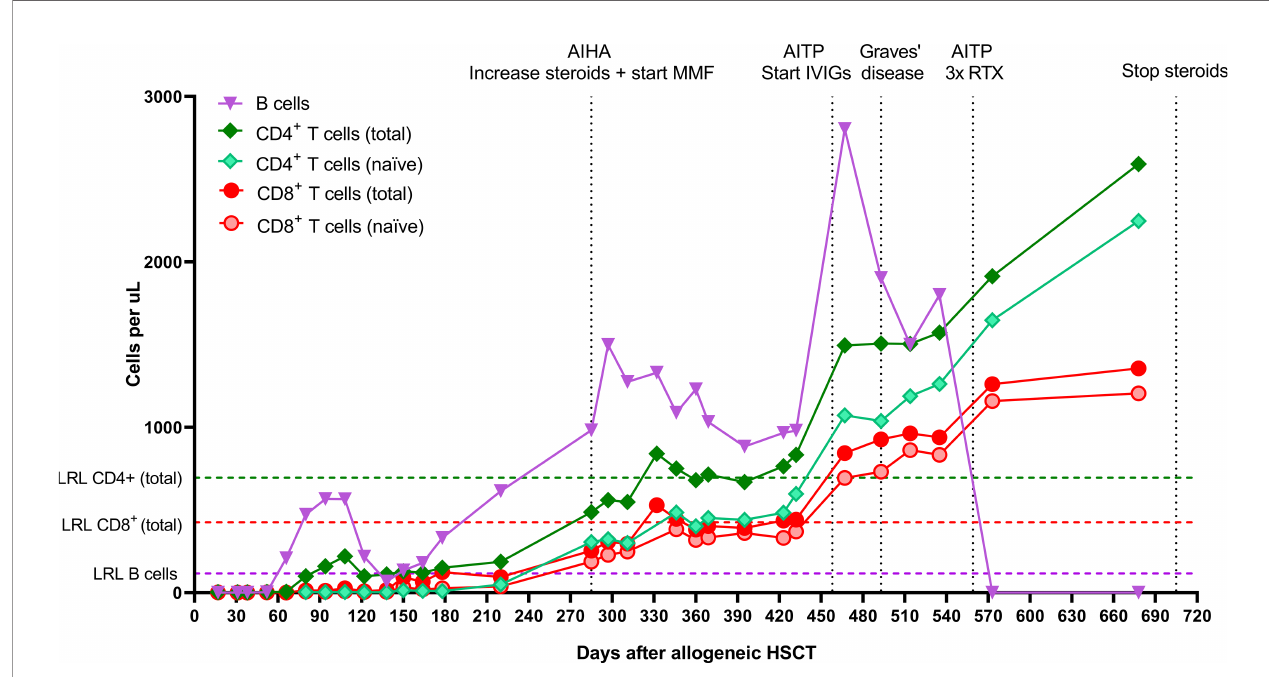
FIGURE 4 | Absolute CD8 + T cell, CD4 + T cell, and B cell numbers after allogeneic HSCT. CD27 + CD45RA + T cells were characterized as naïve T cells. AIHA, autoimmune hemolytic anemia; MMF, mycophenolate mofetil; AITP, autoimmune thrombocytopenia; IVIGs, intravenous immunoglobulins; RTX, rituximab; LRL, lower reference limit; HSCT, hematopoietic stem cell